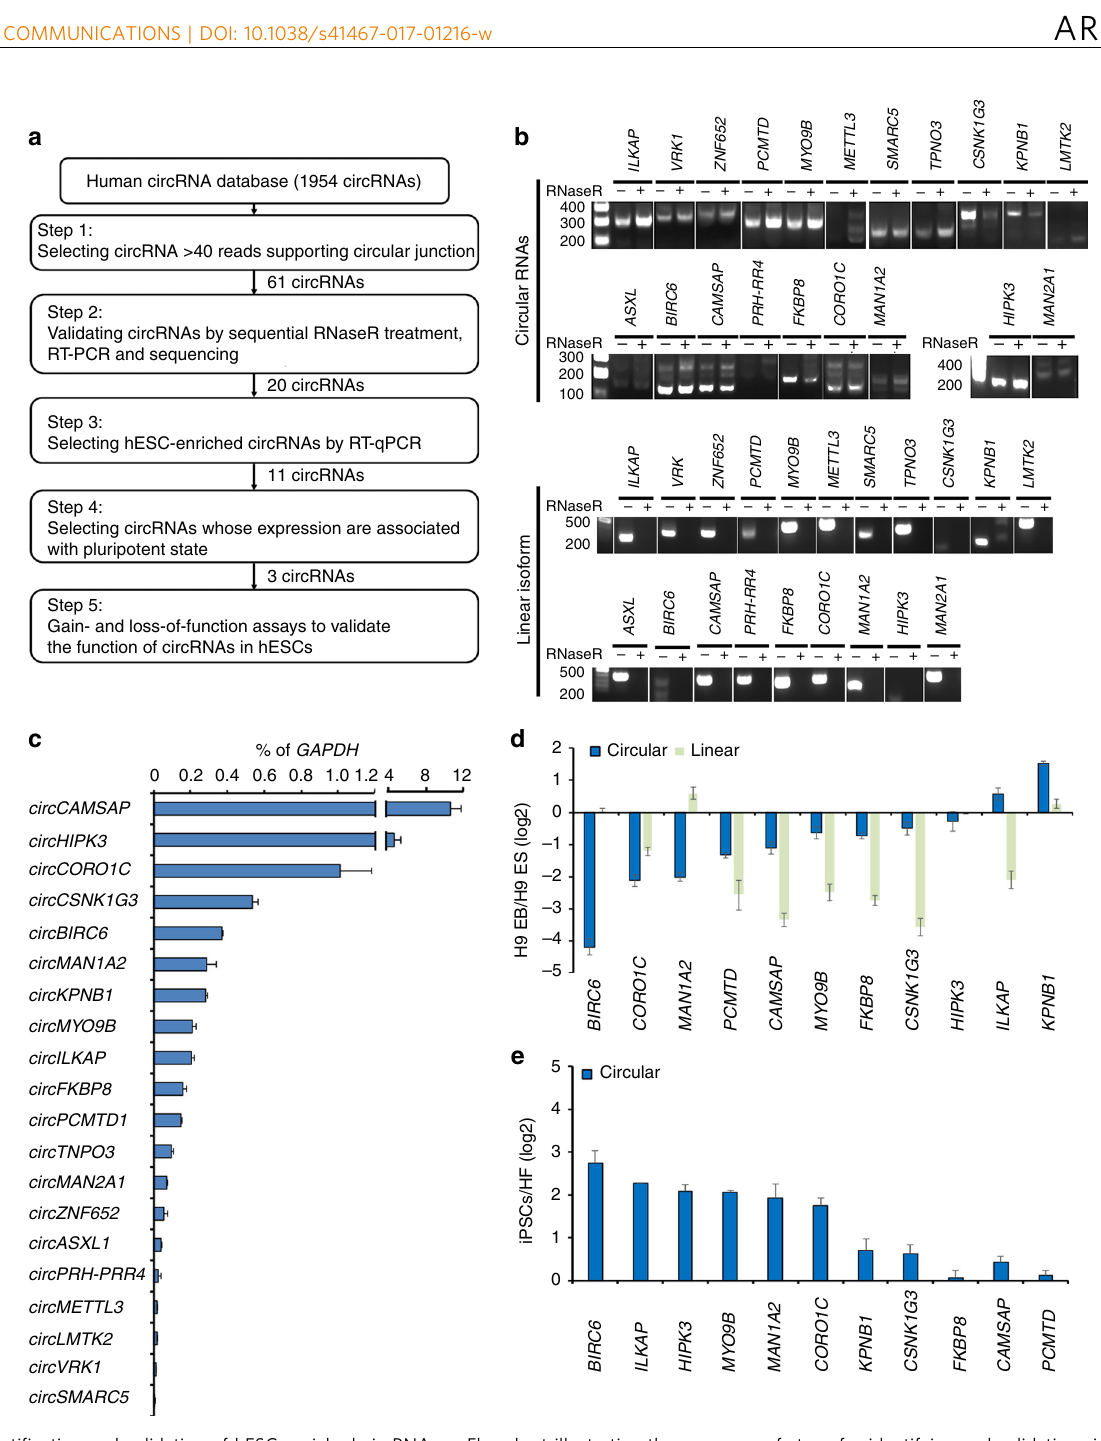
Fig. 1 Identi fi cation and validation of hESC-enriched circRNAs. a Flowchart illustrating the sequence of steps for identifying and validating circRNAs enriched in hESCs. b RT-PCR validation of circRNAs and their linear isoforms from RNaseR-treated RNA samples isolated from hESCs. Speci fi c primers were used to distinguish the indicated circRNAs from their linear isoforms. c The expression level of indicated circRNAs in hESCs by RT-qPCR analysis. The expression of circRNAs was normalized to GAPDH . d Comparison of the expression levels of indicated circRNAs and linear isoforms between hESCs and their differentiated derivatives (H9-EB) by RT-qPCR analysis. e Comparison of the expression levels of the indicated circRNAs between OSKM- reprogrammed iPSCs and their parental fi broblasts (HFs) by RT-qPCR analysis. Quantitative data from three independent experiments is presented as mean ± SD (error bars). P -values were determined by two-tailed two-sample t -tests (* P < 0.05; ** P < 0.01; *** P < 0.001)